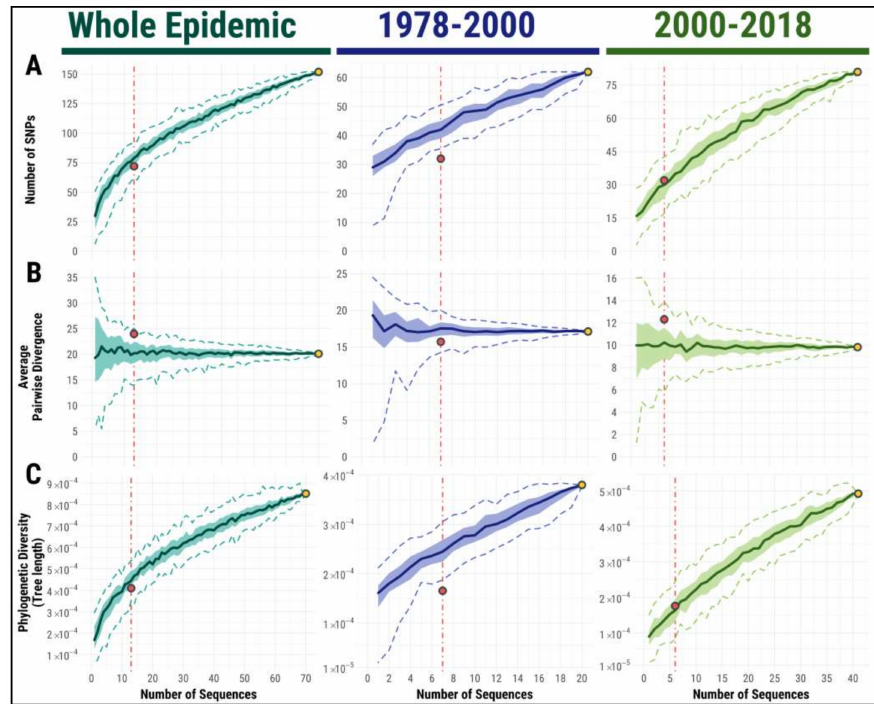
Figure 4. Dependence of genetic diversity and phylogenetic information on the number of ASFV sequences. Estimates of genetic diversity in terms of number of single nucleotide polymorphisms (SNPs) ( A ), average pairwise number of nucleotide differences among sequences ( B ), and phyloge- netic diversity ( C ), as a function of the number of sequenced samples. The curves are computed for both the whole Sardinian epidemic, and for epoch 1 (1978–2000) and epoch 2 (2000–2018), separately. Dashed lines represent the 95% CI and ribbons represent the inter-quartile range for the estimates. The dots illustrate the values for all Sardinian sequences included in this work (in yellow) and for all previously published Sardinian sequences (in